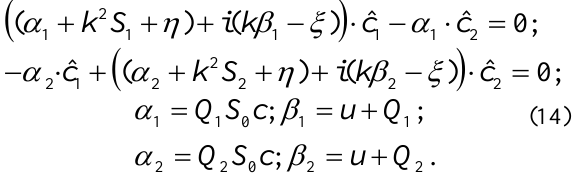
Fig. 1. Unstable branch A of the curve η=η(k) for different flow velocities: 1: u=0.0 ; 2: u=0.1 ; 3: u=0.25 ; 4: u=0.50 ; 5: u=0.75 ; 6: u=1.0